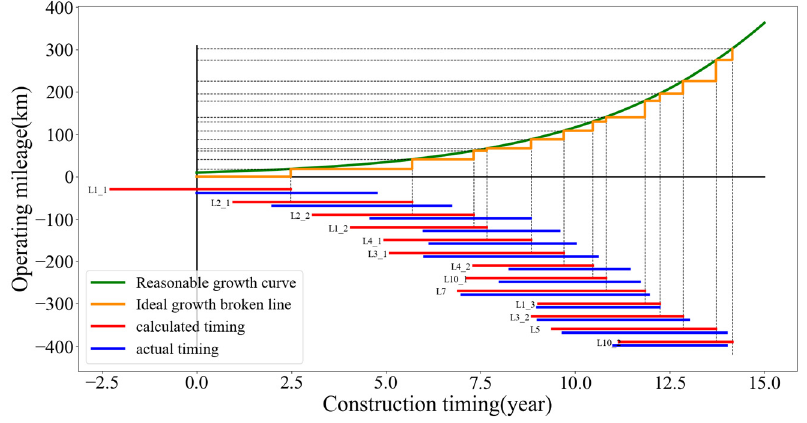
Figure 8. The actual and calculated construction timing of the different phases of construction.